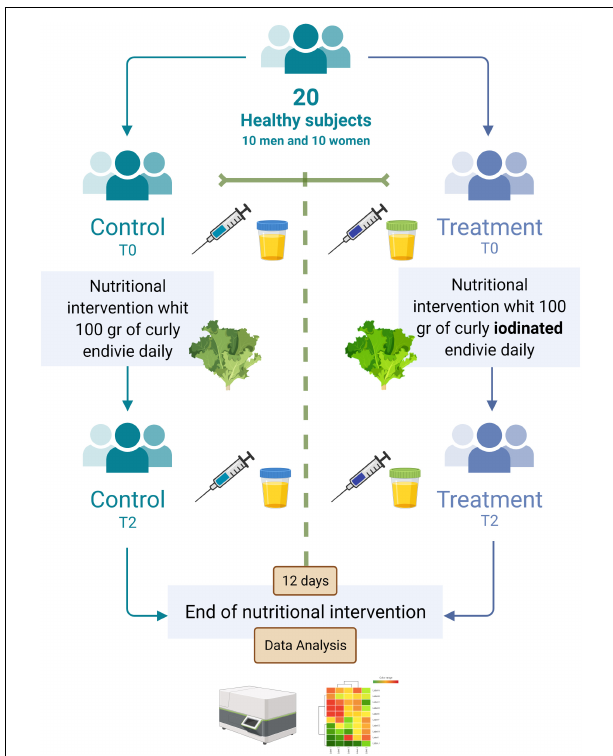
FIGURE 2 | Cluster heat map analysis summarizing the blood and urinary parameter response to a factorial experiment with two sampling times, namely, T0 and T2 (T0 = baseline and T2 after 12 days post-biofortification) and gender M and F (F = female, M = male). The figure was generated using the https://biit.cs.ut.ee/clustvis/ program package with Euclidean distance as the similarity measure and hierarchical clustering with complete linkage. The statistical software attributed colors from red to blue as the values of the measurement decrease. From blue to red as the values